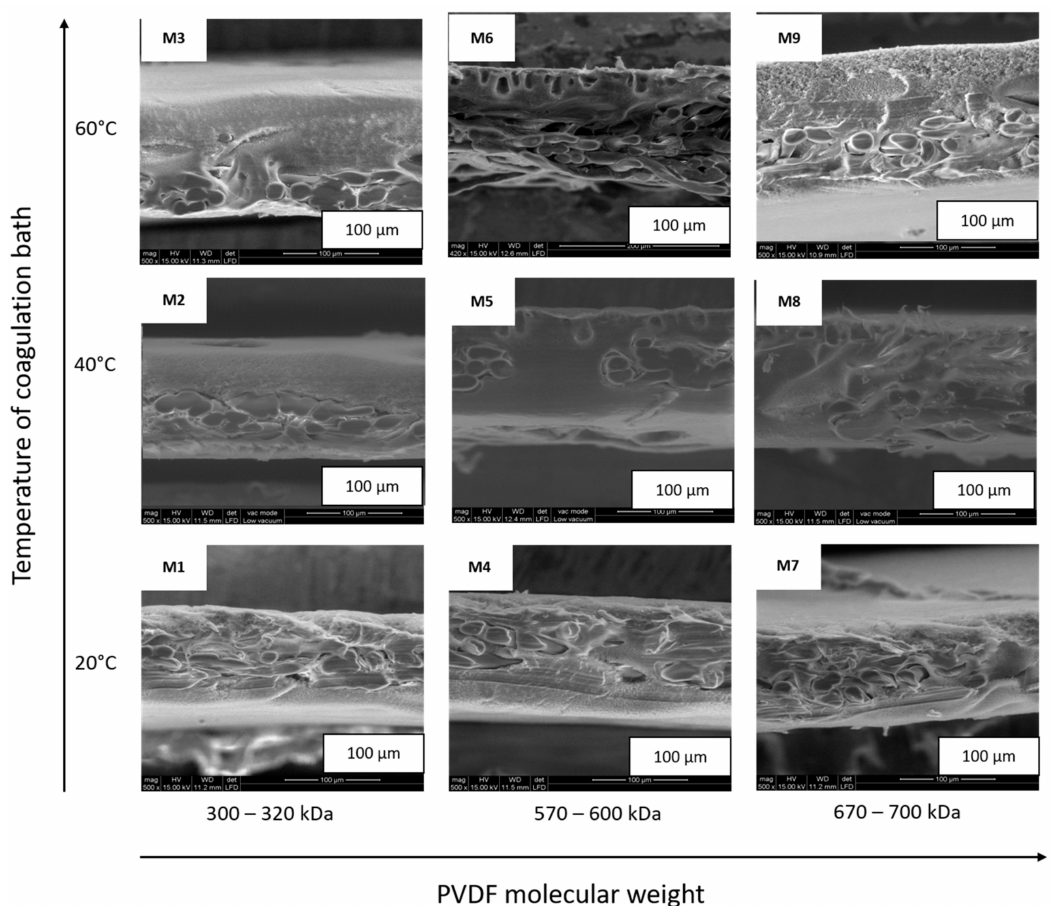
Figure 5. ESEM micrographs of the M1–M9 membrane